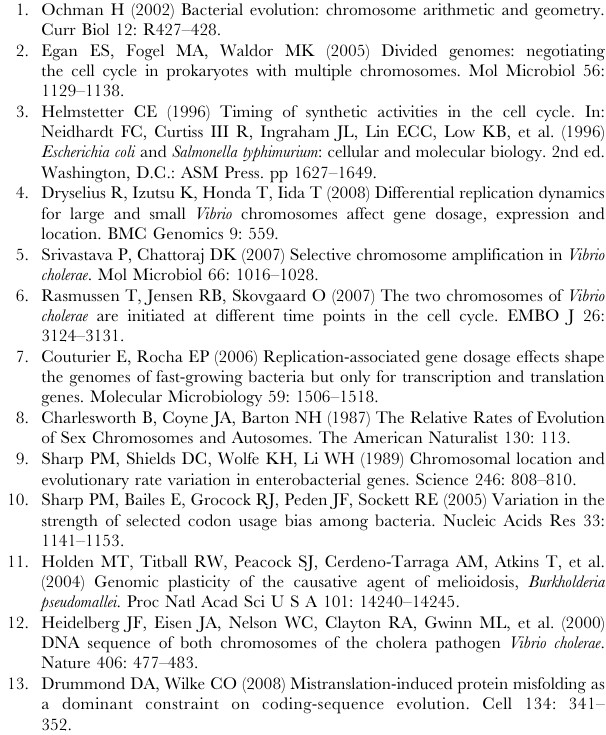
Table S2 ANOVA among evolutionary rates (dN and dS) within Burkholderia by panortholog chromosome location. Table S3 ANOVA of the evolutionary rate dN among Vibrio genomes by panortholog chromosome location. dS analysis was omitted because of unreliably high estimates (means . 1). Table S4 Analysis of distributions of evolutionary rates among panorthologs within Burkholderia cenocepacia sharing a common phylogeny of (((J2315,PC184),MCO-3),AU1054,HI2424). Table S5 Alternative phylogenies of panorthologs identified in B. cenocepacia strains HI2424, AU1054, MCO-3, PC184, and J2315. Table S6 Skewness and Kurtosis ( 6 SE) of distribu- tions of dN and dS measurements from each panortholog set (groups a-e as in Figure 1). Skewness and kurtosis are considered significant if the ratio of the coefficient to its standard error is greater than 2. All distributions except those denoted with an asterisk (*) are significantly skewed or peaked. Smaller coefficients suggest weaker purifying selection as the median approaches the mean.